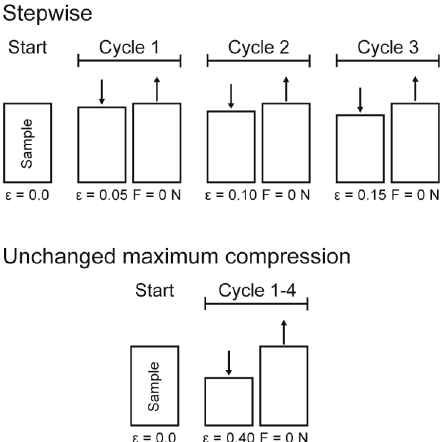
Figure 16. Sketch of the experimental procedure of the quasistatic stepwise cyclic compressions tests and of the quasistatic cyclic compression tests with unchanged maximum compression. During the stepwise cyclic tests, three compression cycles were performed on each sample: first the sample was compressed until 5% strain, then the traverse was lifted until a force of 0 N was reached. The second and the third cycles were performed in a similar manner, only with a different maximum strain (10% and 15%, respectively). During the cyclic tests with unchanged maximum compression, four cycles were performed, each with the same procedure: the sample was compressed until 40% strain, then the traverse was lifted until a force of 0 N was reached. Data obtained from the cyclic compression tests were the residual strains after each cycle and— only for the cyclic test with unchanged maximum strain—energies absorbed/released/dissipated (absorbed energy E a , released energy E r and dissipated energy E d , in form of energy densities ED). The